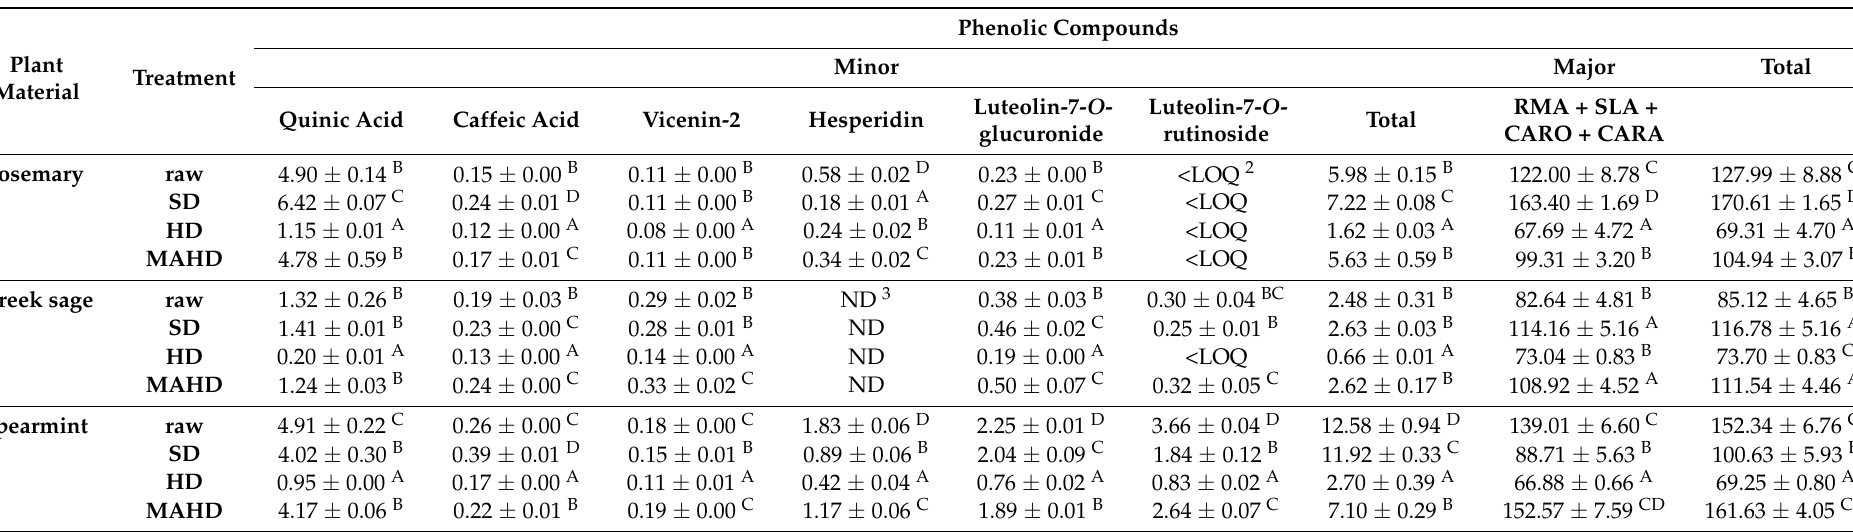
Table 3. Minor, major and total phenolic compounds (in mg/g) quantified in rosemary, Greek sage and spearmint distillation residues after the recovery of essential oils by steam-distillation (SD), hydro-distillation (HD) and microwave-assisted hydro-distillation (MAHD) by HPLC-DAD-MS 1